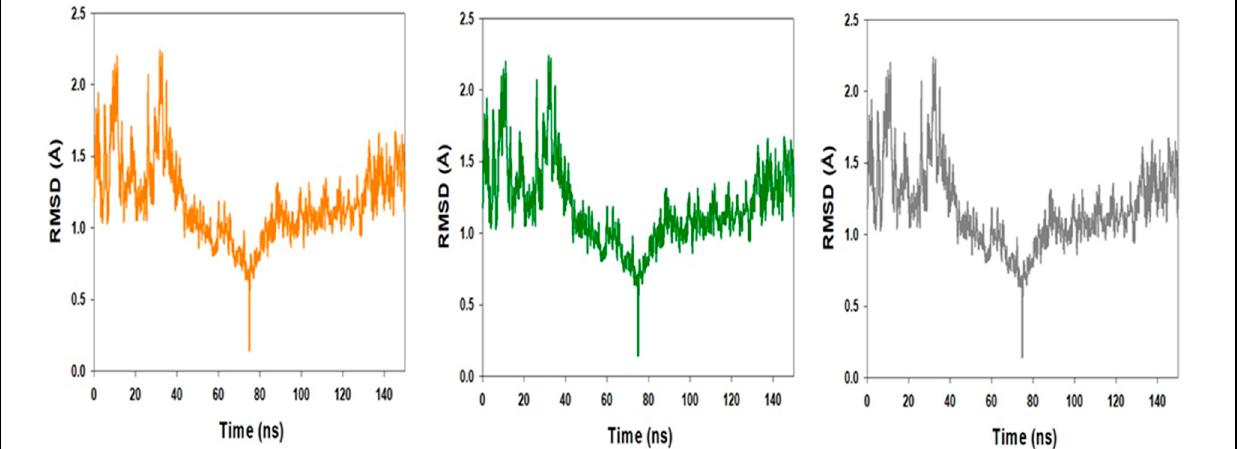
Figure 15. MD simulation trajectory analysis of Root Mean Square Divisions (RMSD) of compound 1 bound with LSD; 150 ns time frame in triplicate displayed.